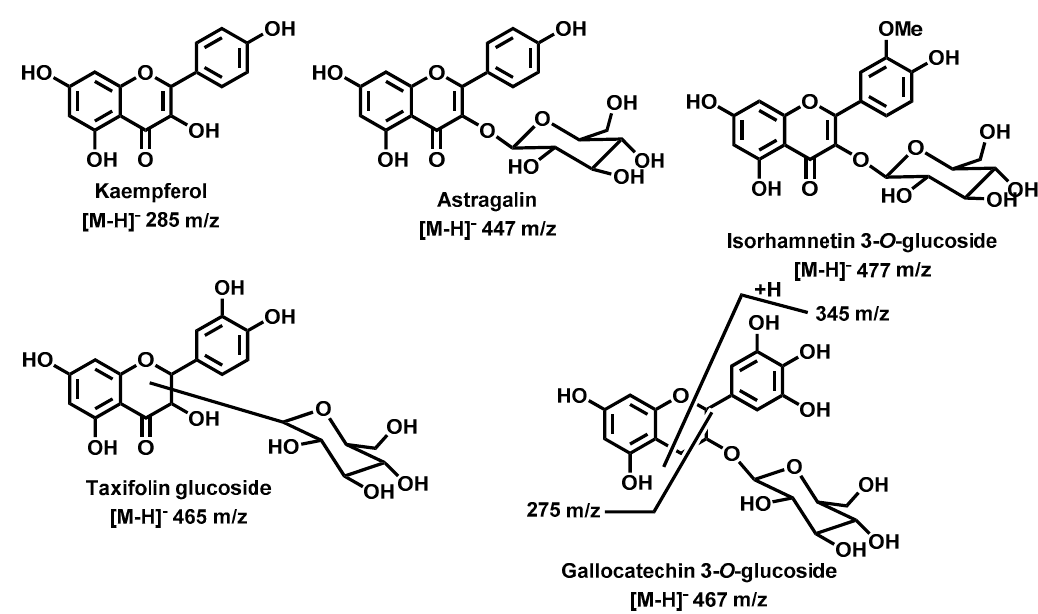
Figure 8. Other polyphenolic derivatives identified in G. tridentata extracts.